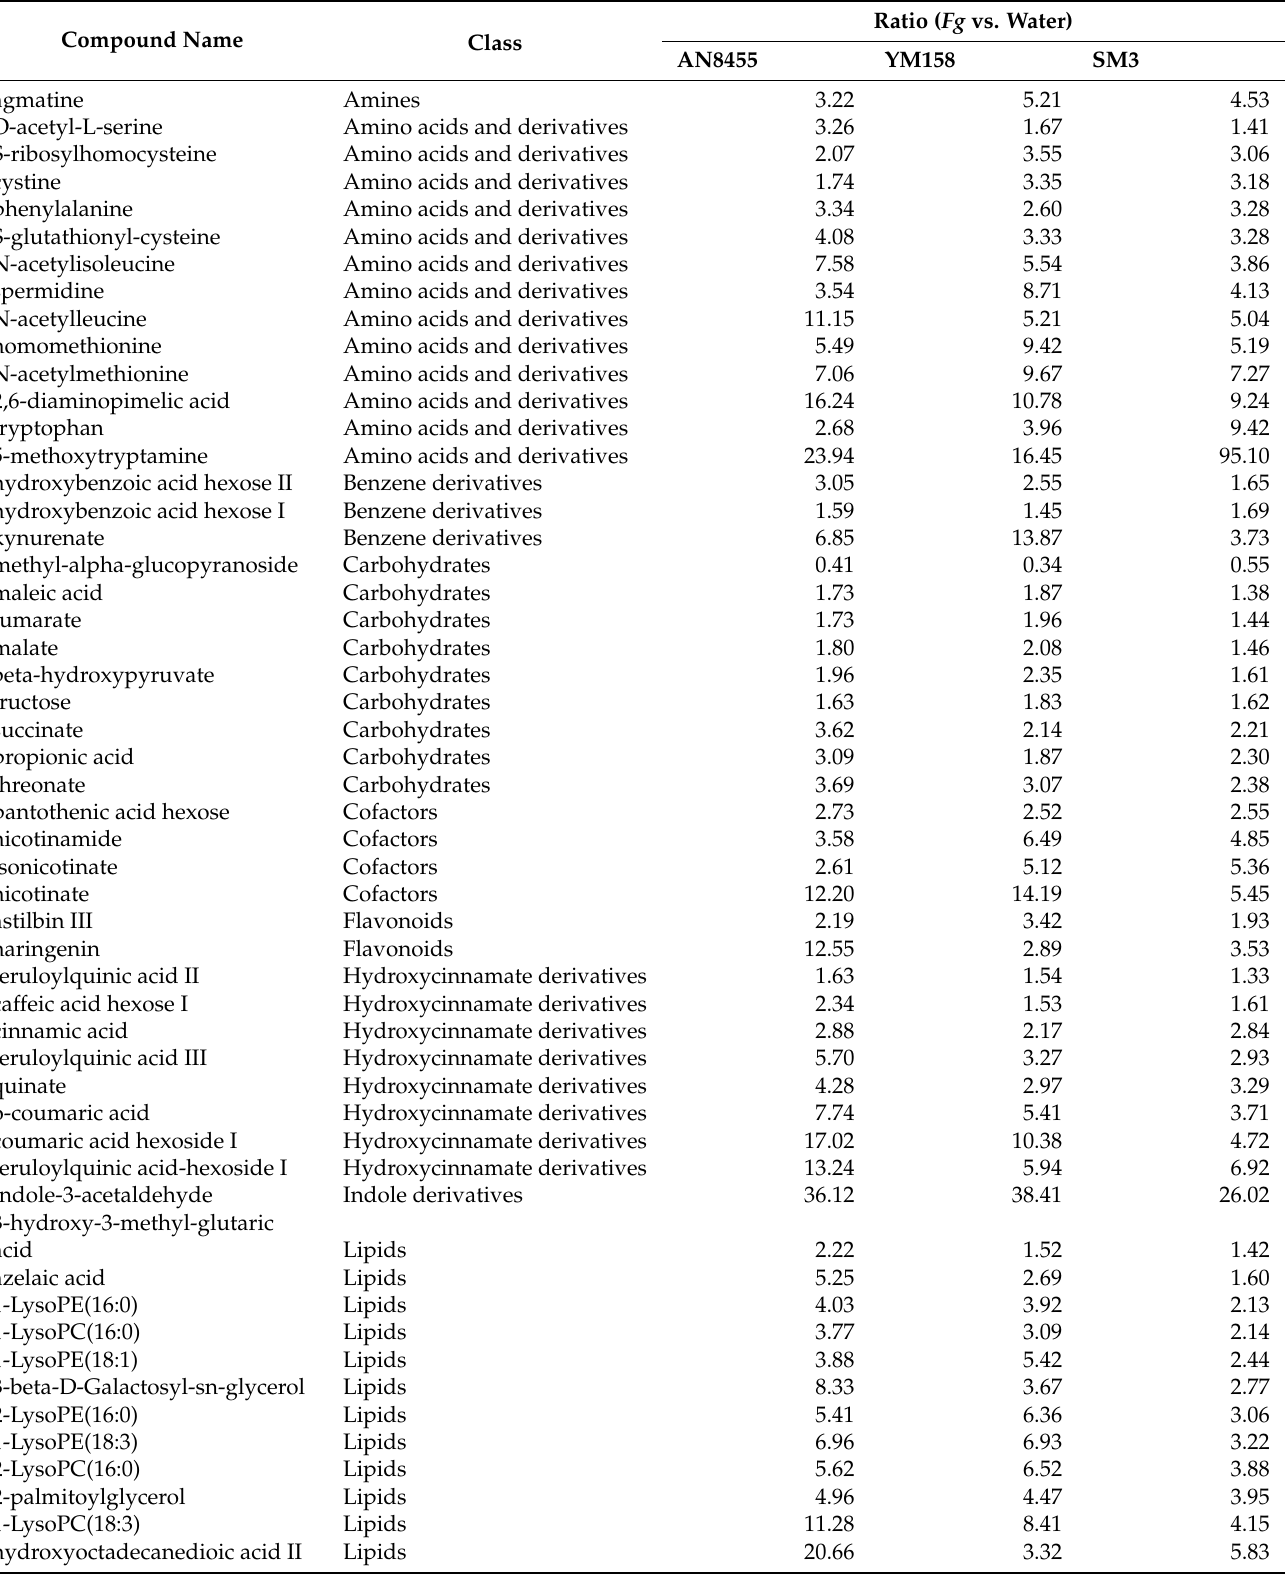
Table 1. List of significantly changed metabolites in all three varieties post Fg